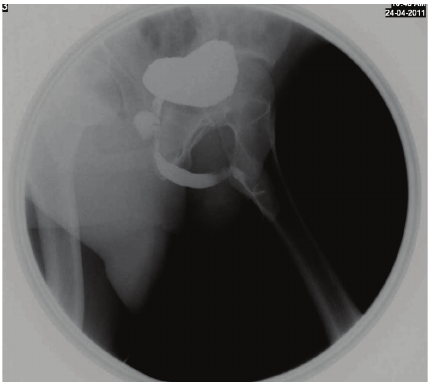
Figure 1: VCUG showing a small rounded cystic outpouching from the ventral aspect of the proximal bulbar urethra-Cowper’s gland syringocele.